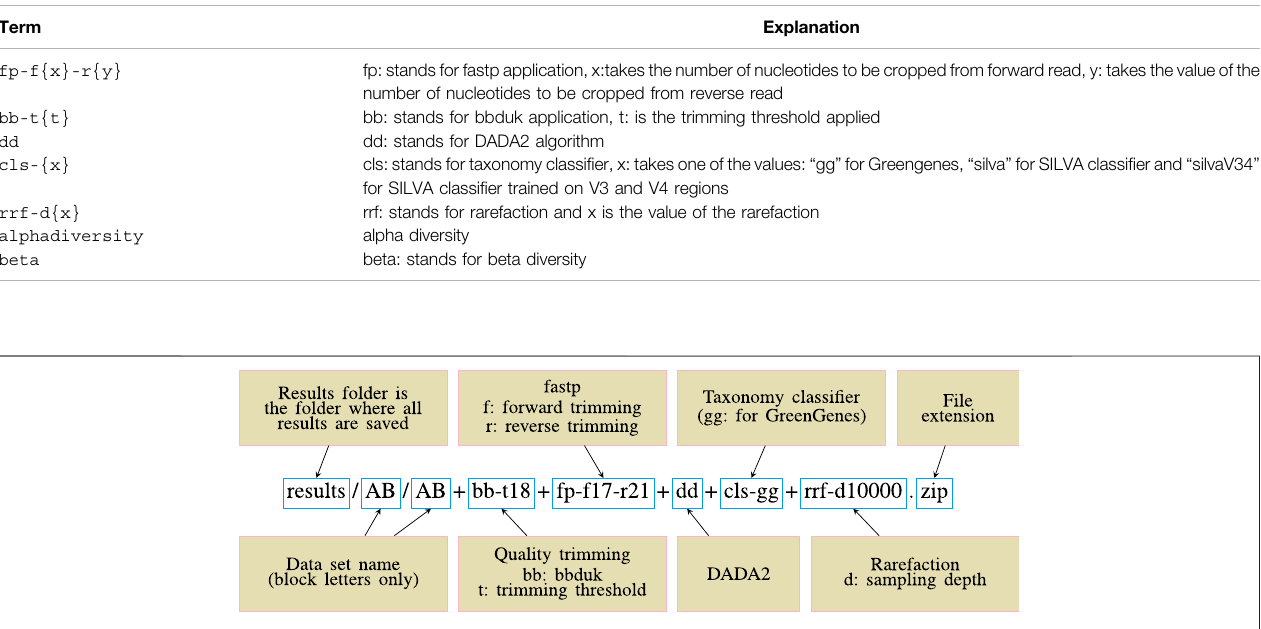
TABLE 1 | Output nomenclature.